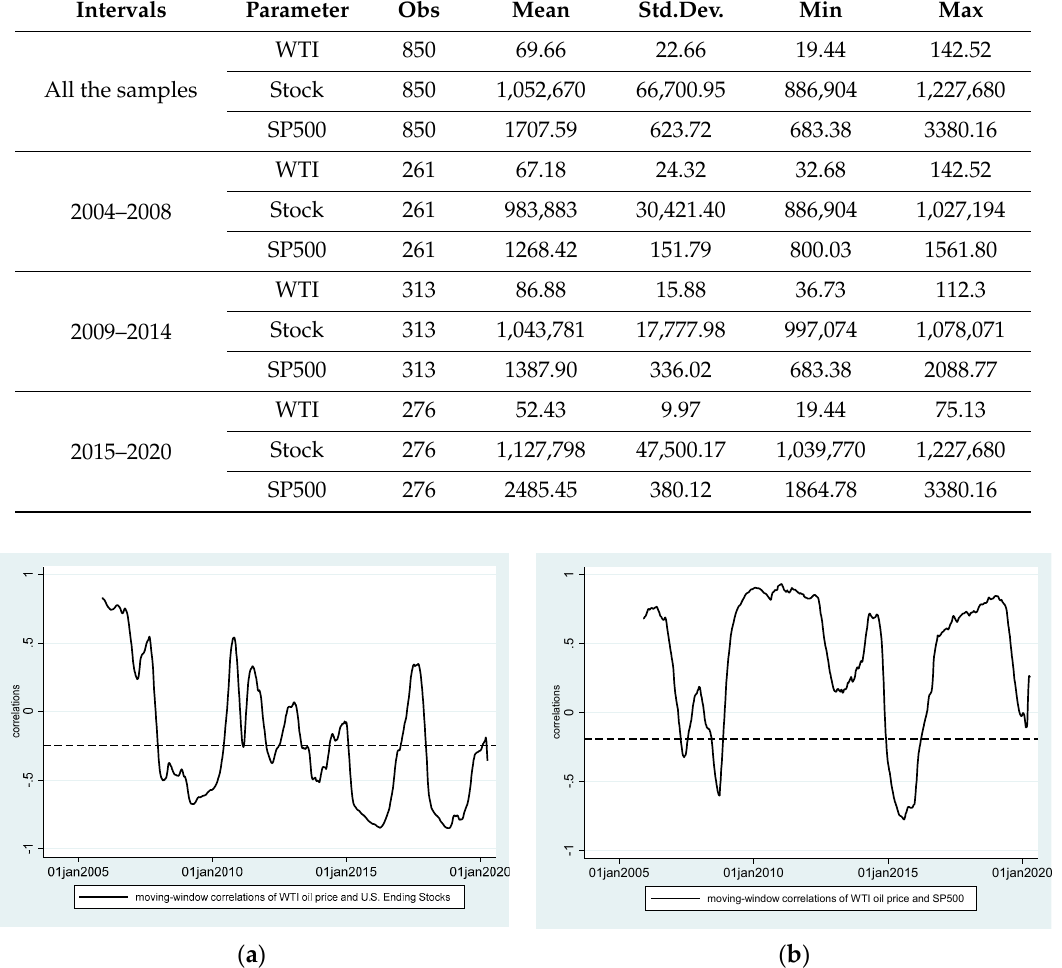
Figure 2. Moving-window correlation coefficient. Note: Figure 2 (a) shows the moving-window correlation coefficient between WTI crude oil price and U.S. ending stocks, while Figure 2 (b) shows the moving-window correlation coefficient between WTI crude oil price and SP500. In this paper, the moving width is designed as 100, which can avoid the uncertainty of increasing the correlation coefficient due to a too-short time window, and it can also reduce the time window that is too long to cover up too much information. The dotted line in the figure shows the static correlation coefficient. The correlation coefficient between WTI crude oil price and the ending inventory in the United States is − 0.2490. The correlation coefficient between WTI crude oil price and the S&P500 index is –0.1290.